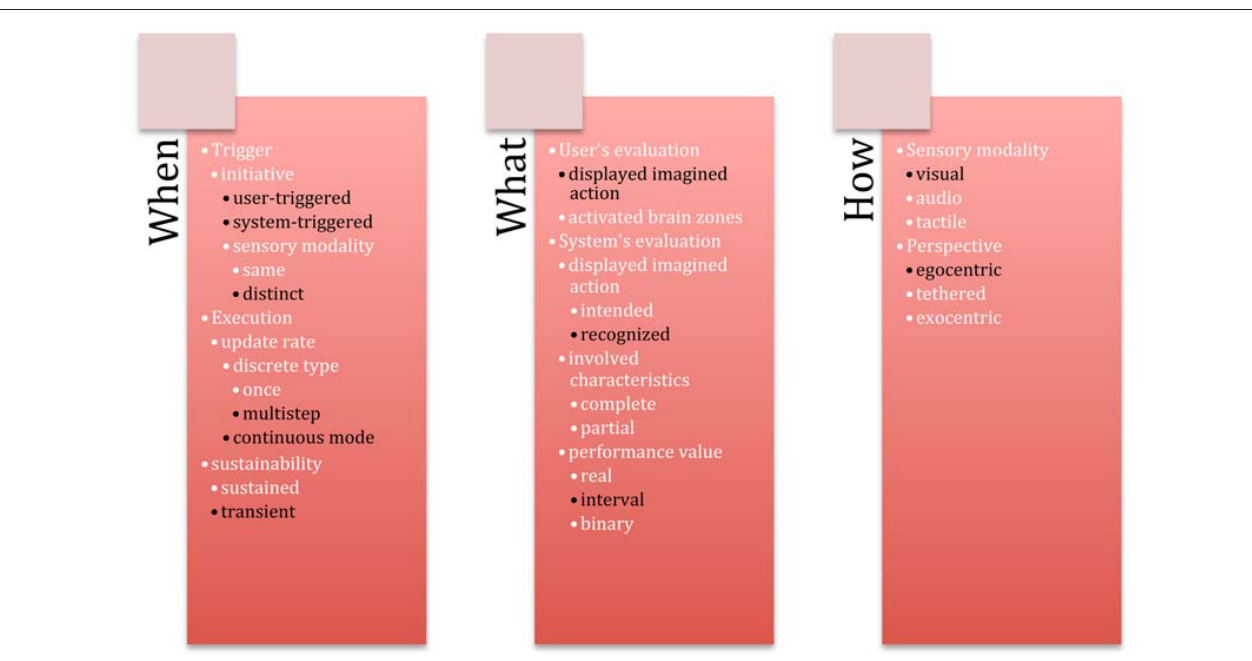
FIGURE 8 | Analysis of the system of Kosmyna et al. (2015) within the proposed guiding system. The options covered by the system of Kosmyna et al. (2015) are represented in black.